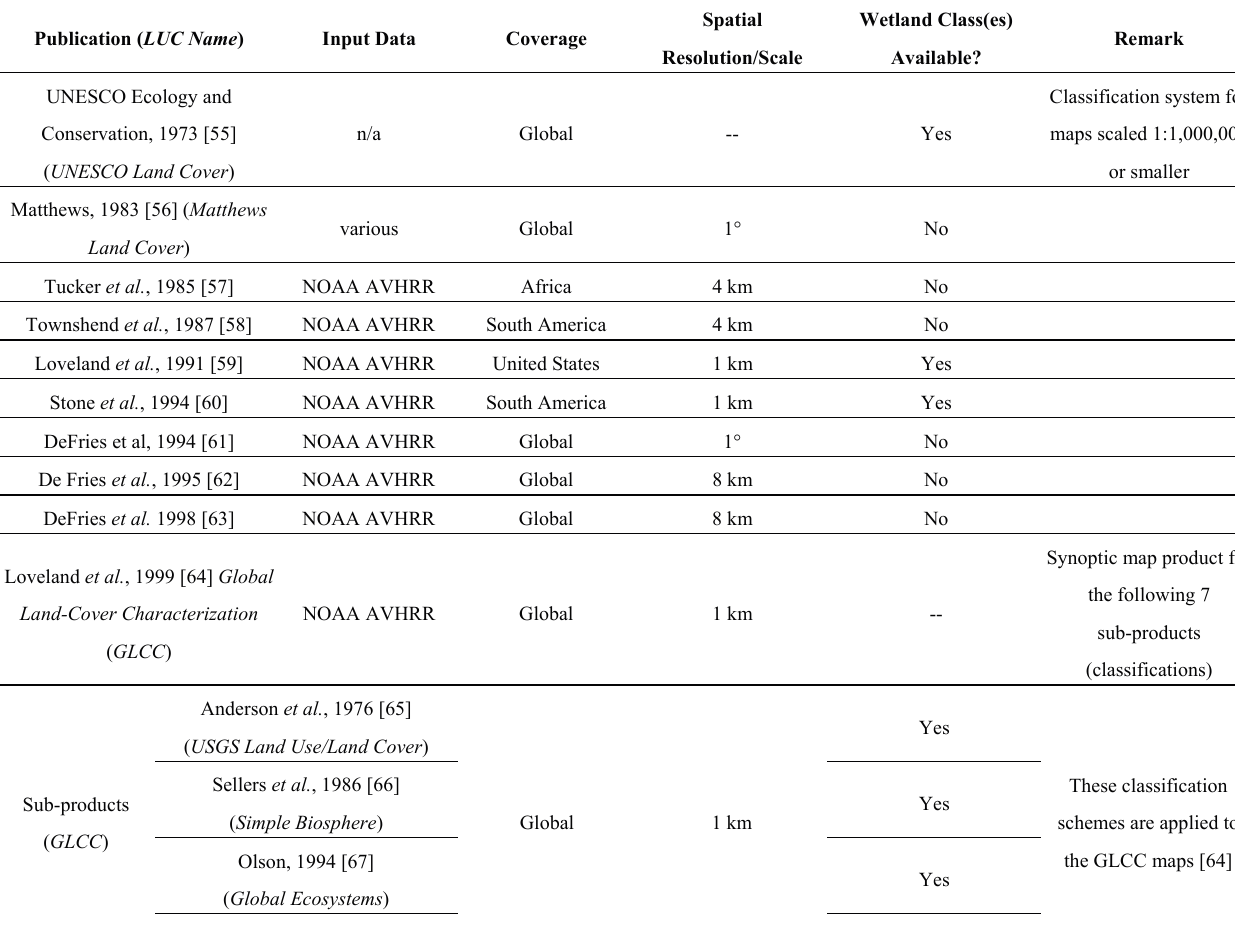
Table 3. Land use/land cover classification (LUC) systems compiled with remote sensing data relevant to wetland classes. GLC2000, Global Land Cover